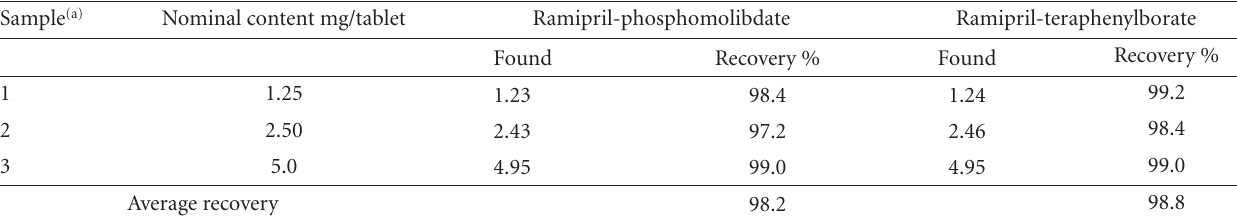
Table 4: Determination of ramipril in some pharmaceutical